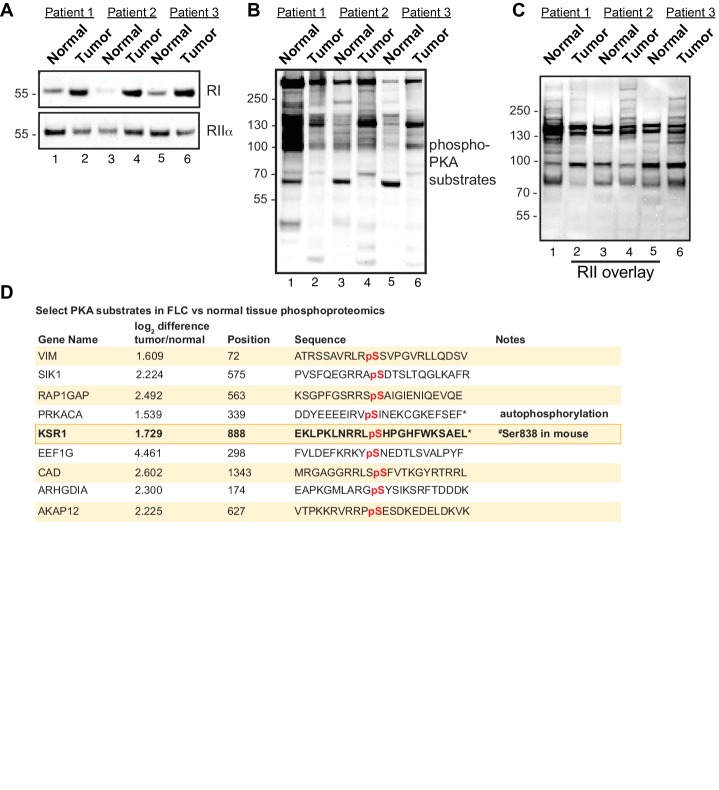
Altered PKA signaling in FLC.(A) Immunoblots of paired normal adjacent liver and tumor from FLC patients probed with antibodies to RI (top) and RIIα (bottom). (B) Immunoblots of the same samples probed with an antibody recognizing phospho-PKA substrates (R-R-X-pS/pT). (C) RII overlay analysis to detect AKAPs in the same samples (D) List of select PKA substrates elevated in phosphoproteomic analysis of FLCs. Phosphorylated residues (red) and the scaffold protein KSR1(bold) are indicated.